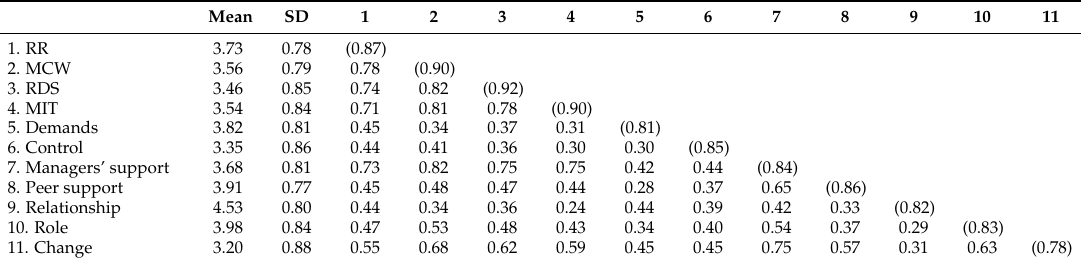
Table 2. Means, standard deviations and Pearson’s correlation coefficients between the research variables (Cronbach’s alpha in